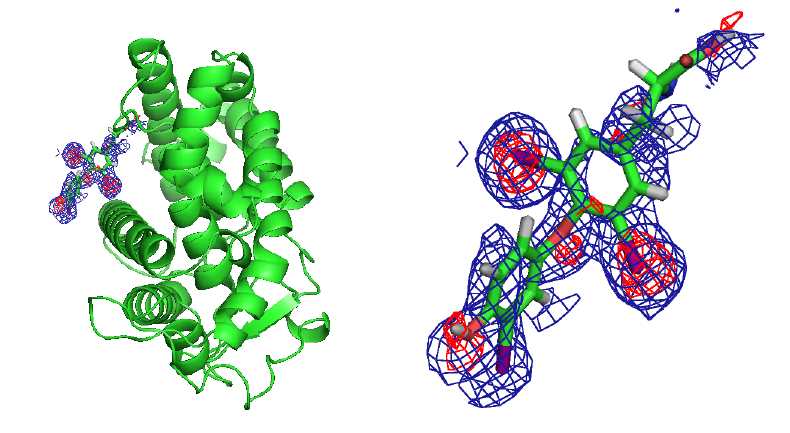
Figure 6. The other ligand is attached to the surface of the reconstructed model.